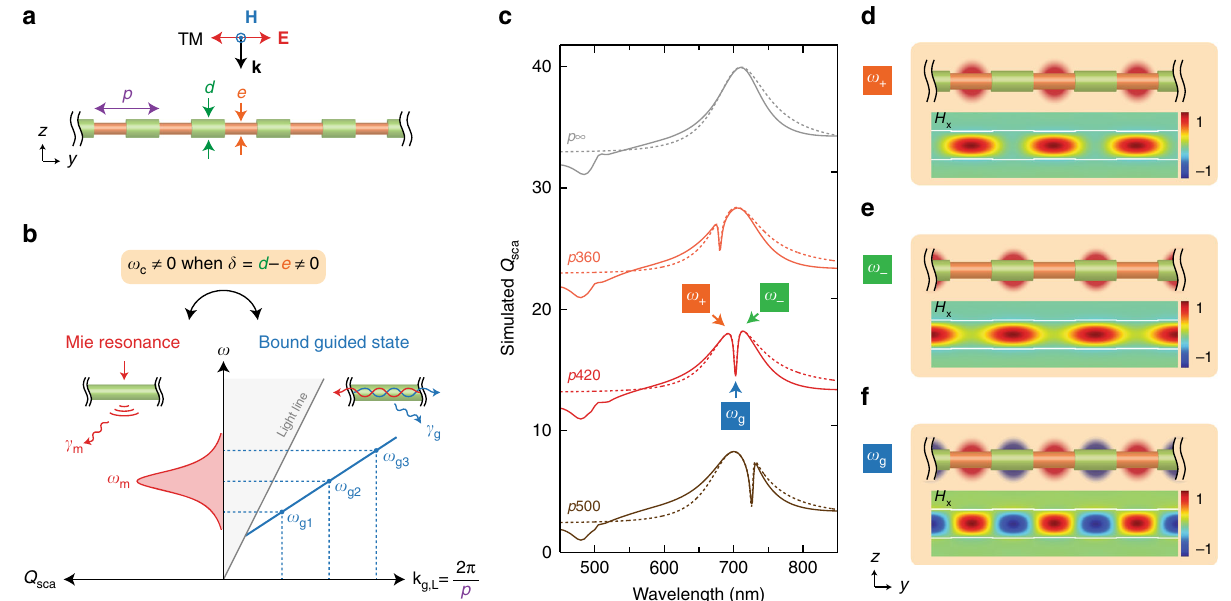
Fig. 1 The geometry and coupled resonances of a NW GSL. a Structure and illumination geometry of a Si NW GSL. b Schematic illustration of a leaky Mie resonance with a broad spectral envelope (left) and a continuum of BGS states (right), in which a speci fi c BGS state, ω g , is selected by the choice of pitch p . c Numerically calculated spectra of Q sca (solid lines) and analytical fi t by TCMT (dotted lines) for an in fi nite NW with uniform d ( δ = 0) of 140 nm (gray) and for NW GSLs with d = 140 nm, e = 135 nm, and varying p of 360 nm (orange), 420 nm (red), and 500 nm (brown). The pitch, p , in nanometers is denoted for each spectrum, where p = ∞ corresponds to an in fi nite NW of uniform diameter d . All spectra are successively offset vertically by 10. d – f Schematic and calculated magnetic fi eld pro fi les for a GSL with p = 420 nm at frequencies of ω + ( d ), ω − ( e ), and ω g ( f ), corresponding to the red spectrum and labels in c at wavelengths of 692, 713, and 703 nm,